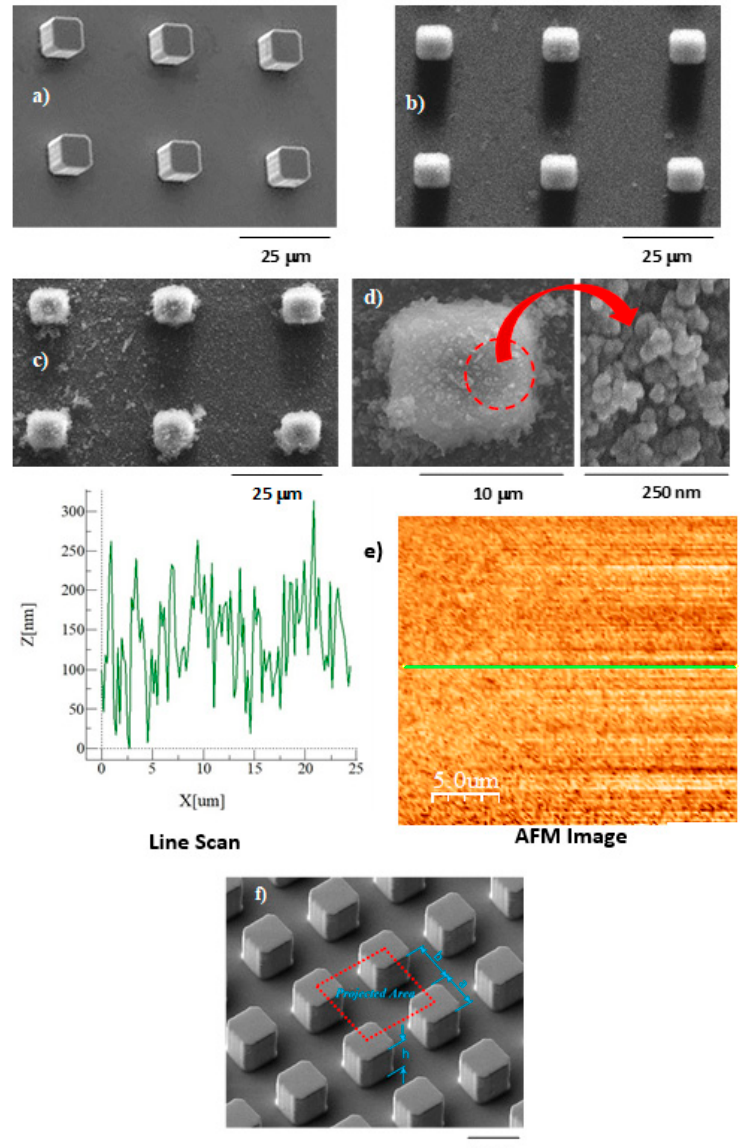
Figure 1. SEM images and AFM line scan of micro ‐ post arrays: ( a ) SEM image of micro ‐ post arrays on a silicon wafer, ( b ) SEM image of replicated micro ‐ post arrays on PDMS, ( c ) SEM image of coated and PDMS replicated micro ‐ post arrays (functional silica nanoparticles are also shown), ( d ) coating deposited micro ‐ post array and close view of the coated surface, ( e ) AFM line scan and image of the coating surface, ( f ) geometric configurations of the micro ‐ post array.